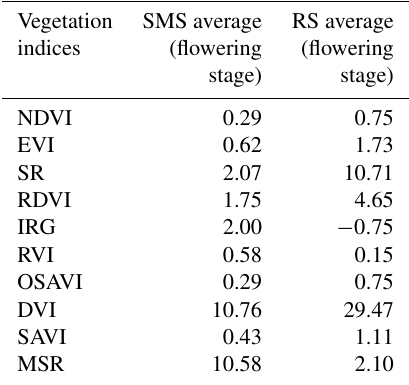
Table 7. Same as Table 3 but for the flowering stage.